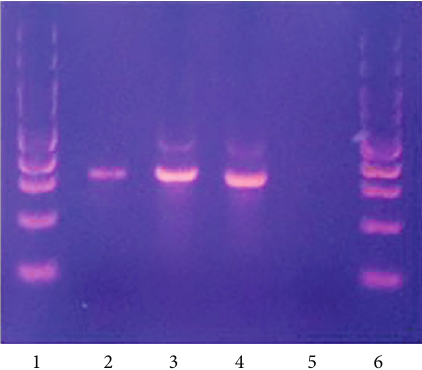
Figure 5: PCR ampli fi ed products (lanes 1 and 6: 100 bp DNA ladder; lane 2: FNAB sample; lane 3: positive control for L. infantum ; lane 4: ATCC NR-50127 positive control for L. tropica ; lane 5: negative control).